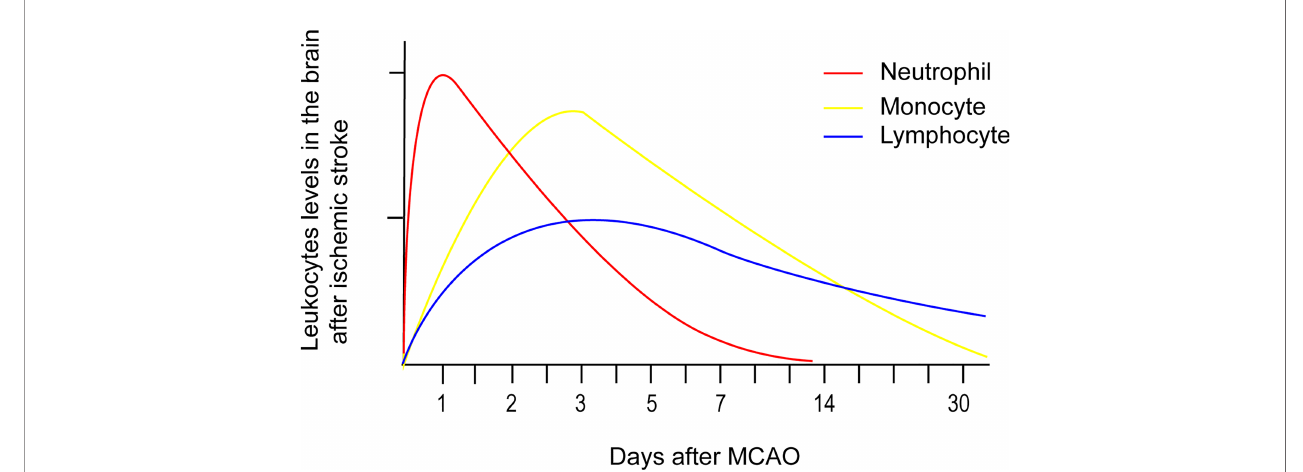
FIGURE 1 | Temporal pro fi le of peripheral immune cells accumulation after stroke onset based on experimental data. Neutrophil accumulation in the ischemic hemisphere increased signi fi cantly after 3 hours, reaching maximum accumulation after 24 hours, followed by a steady dissipation over 7 days. Monocyte counts in the ipsilateral hemisphere robustly increased after 1 day, peaked after 3 - 7 days, and then returned to baseline levels after 14 days. Lymphocytes extravasate into the injured hemisphere in smaller counts and longer persistence compared to the former two immune cells. The accumulation of T cells in the ischemic hemisphere signi fi cantly increased as early as 24 hours after AIS, peaked at 3 days, and persisted for 1